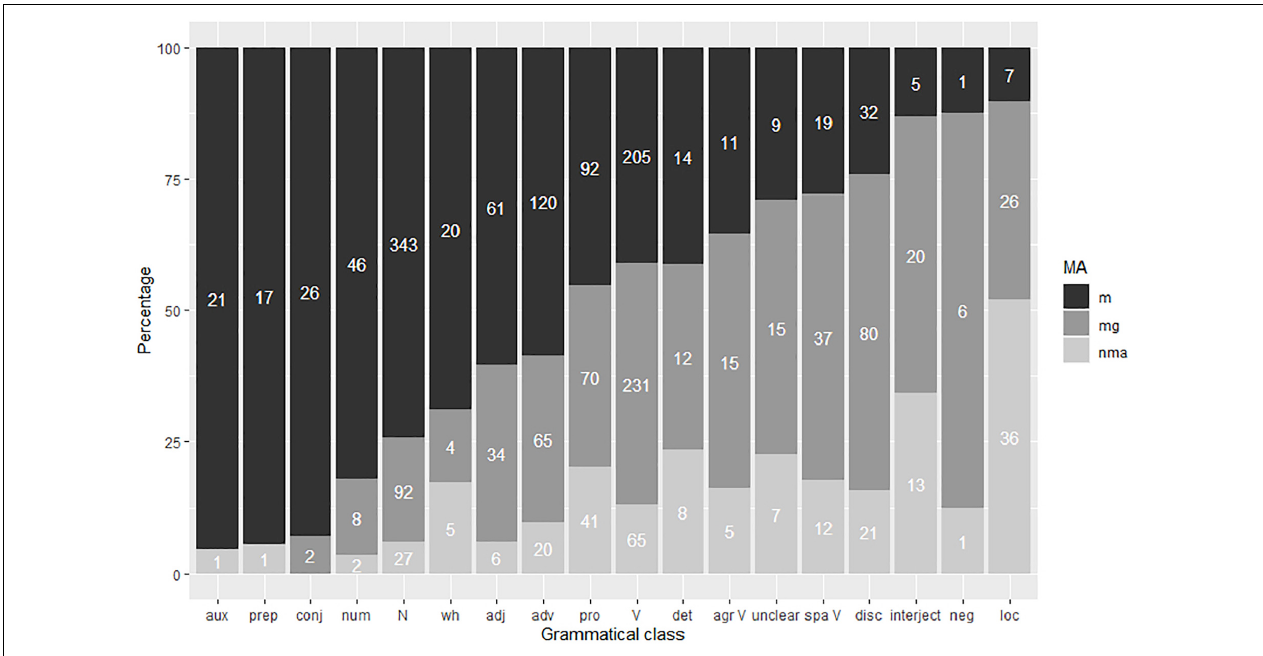
FIGURE 4 | Mouth action rates by grammatical class (ranked by decreasing % of